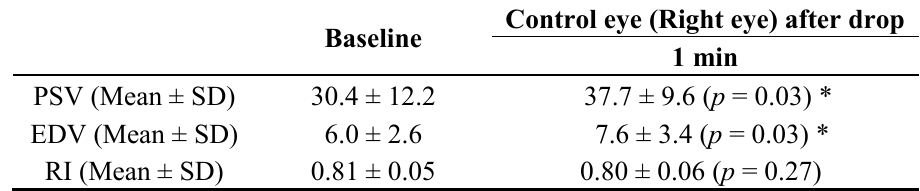
Table 4. Stage 2: Baseline compared to control eye (right eye) after 1 min of